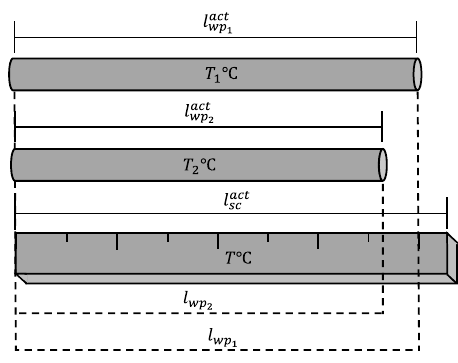
Figure 2. Behavior of the object at different